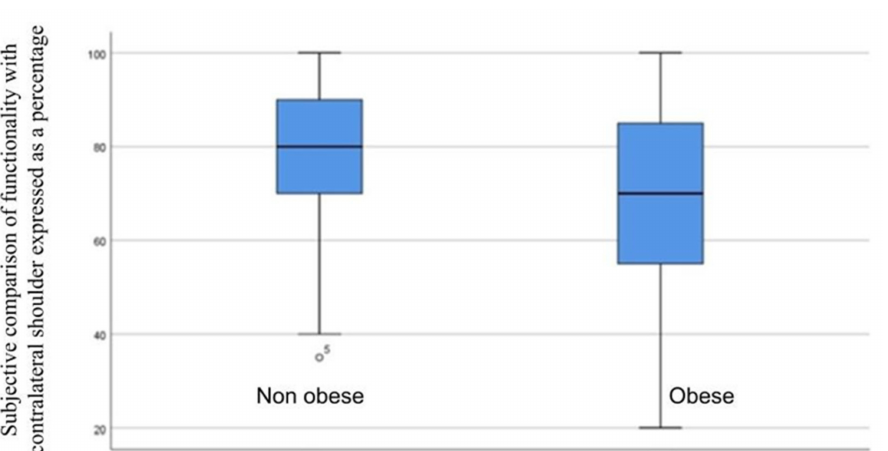
Figure 2. Mann–Whitney U test to compare shoulder function after surgery with the presence of